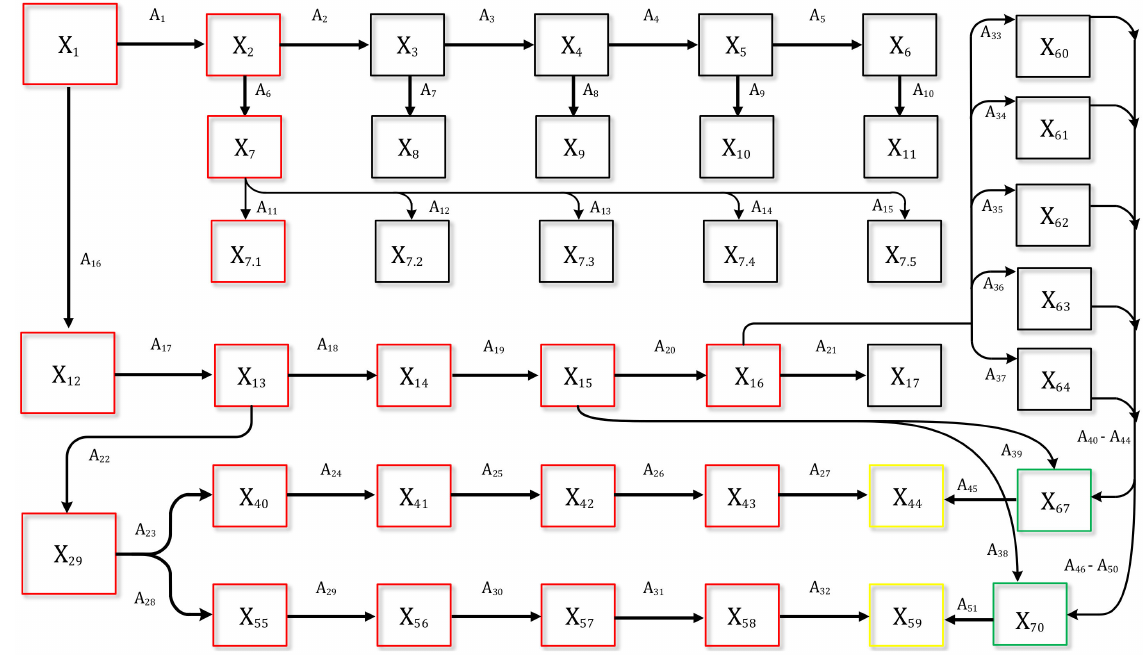
Figure 16. Mixed asymmetric adjacency graph G (cid:48) =